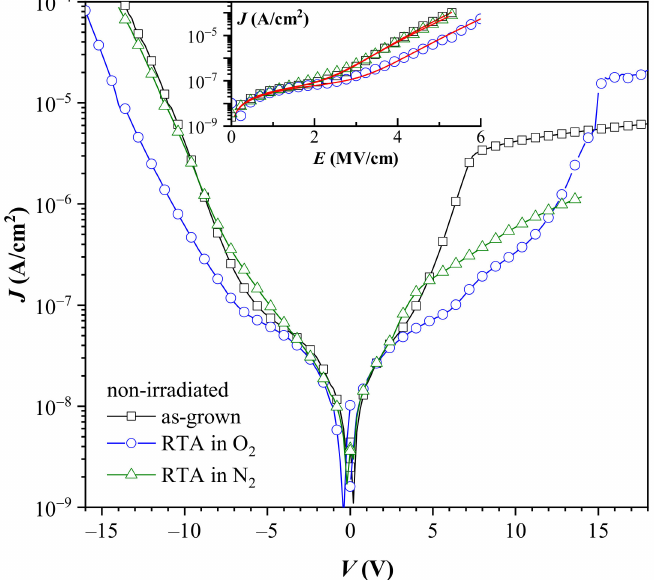
Figure 4. Leakage currents of the non-irradiated stacks. Inset–experimental data for negative applied voltages fitted with a combination of Ohmic and PF conduction (solid